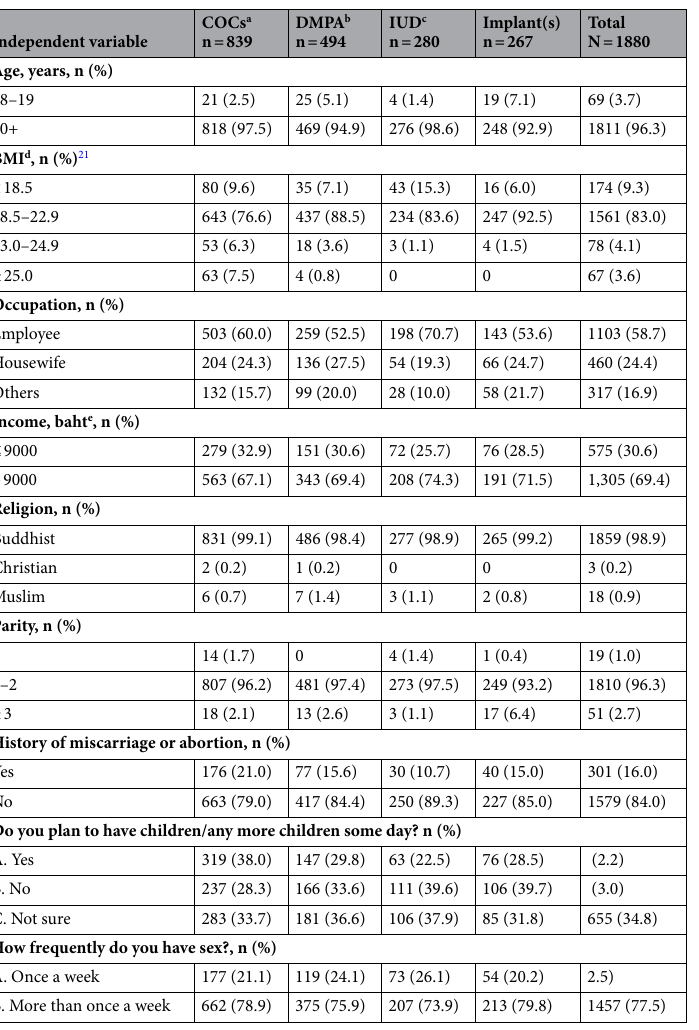
Table 1. Baseline characteristics of the women and their use of the contraceptive method (N = 1880). a COCs: Combined oral contraceptive pills. b DMPA: Depot medroxyprogesterone acetate. c IUD: Copper intrauterine device. d According to the Asian BMI category, < 18.5 was defined as underweight, 18.5–22.9 was defined as normal weight, 23.0–24.9 was defined as overweight, and ≥ 25.0 was defined as obese 18 . e 1 US dollar equals 31.25 Thai baht